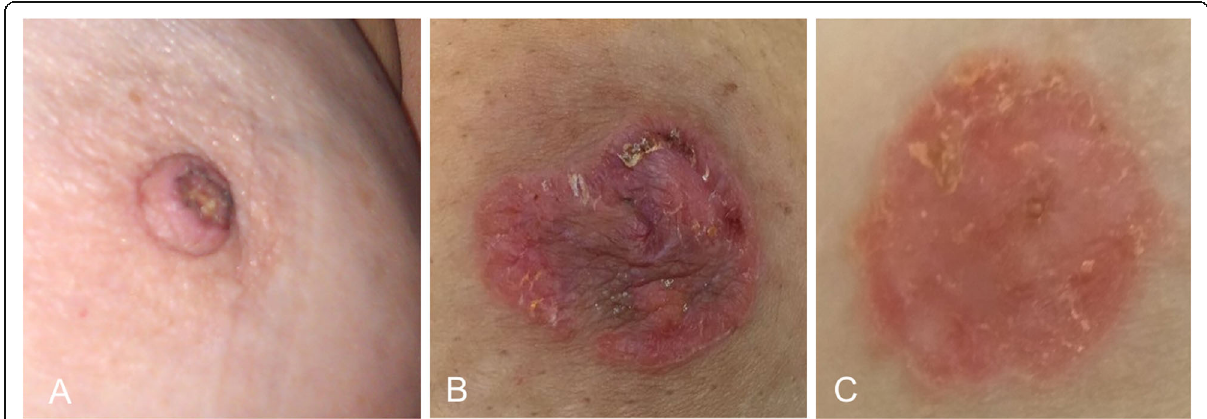
Fig. 31 Cutaneous manifestations of Paget ’ s disease of the nipple. a Crusted ulcerated papule in the center of the nipple. b Scaly erythematous plaque with erosions that destroys the nipple. c Scaly erythematous plaque that covers the entire nipple